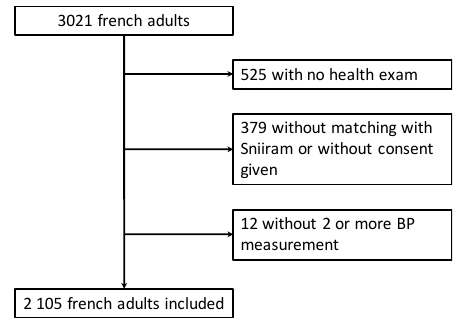
Figure 1. Flow chart, Esteban survey